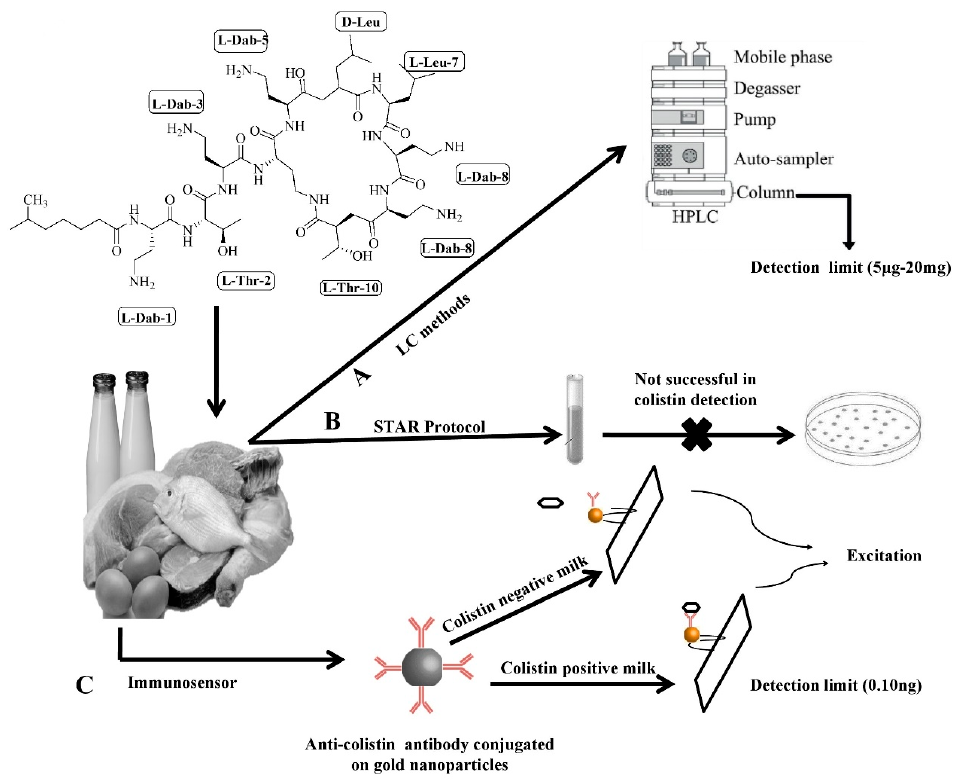
Figure 3. Graphical illustration of different methods used for colistin detection in animal-based food.